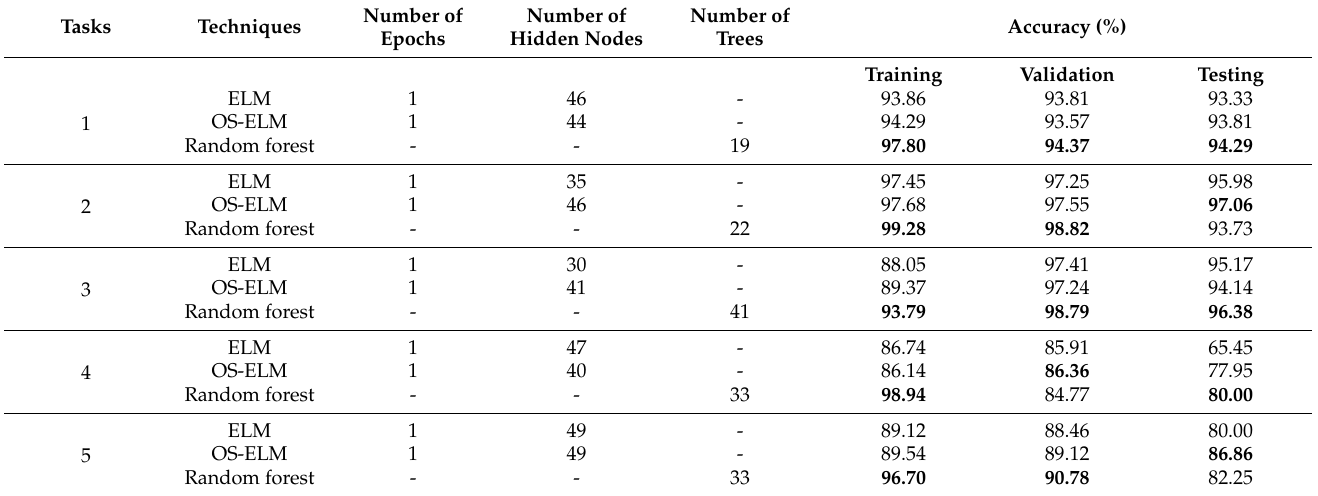
Table 8. The performance comparison among ELM, OS-ELM, and Random Forest network for five classification